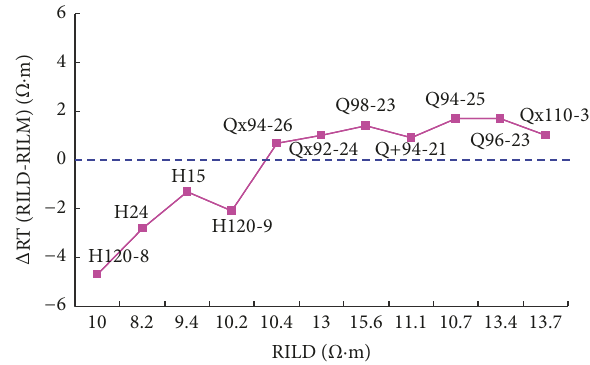
Figure 9: Δ RT and RILD cross plot of thick layer sand bodies at Daqingzijing area.